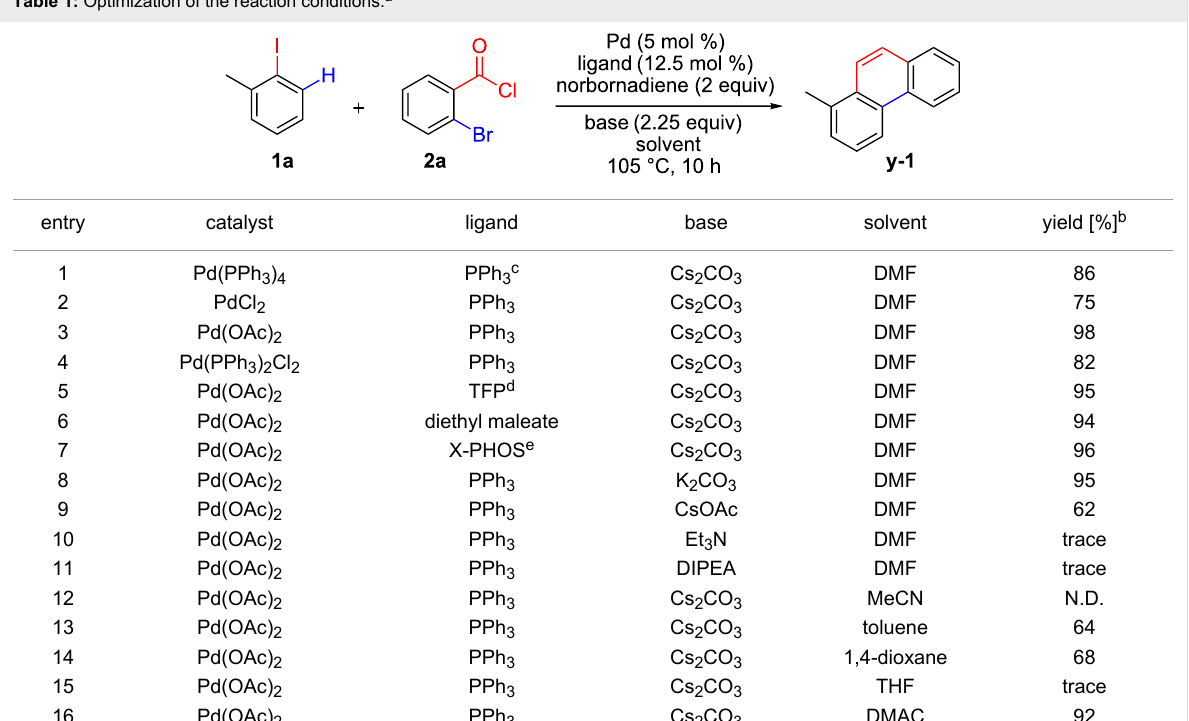
Table 1: Optimization of the reaction conditions.